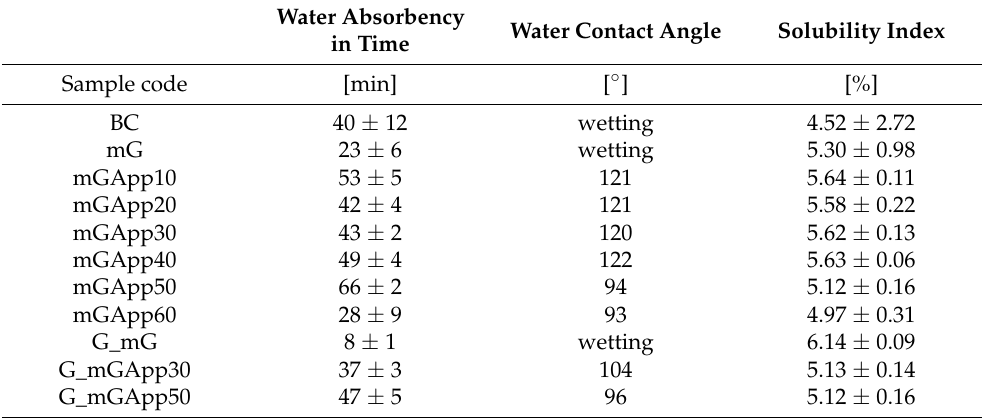
Figure 5. The swelling capacities of materials: bacterial cellulose (BC); bacterial cellulose pre-treated and modified with glycerol (mG and G_mG); bacterial cellulose pre-treated and modified with glyc- erol and by entrapping apple powder (mGApp10; mGApp20; mGApp30; mGApp40; mGApp50; mGApp60; G_mGApp30; and G_mGApp50). ( A ) Bacterial cellulose produced in media without ap- ple powder (mGApp10; mGApp20; mGApp30; mGApp40; mGApp50; and mGApp60); ( B ) bacterial cellulose produced in media with apple powder (G_mGApp30; G_mGApp50). All data are the av- erage of 3 results. Table 1. Water absorbency behavior of the materials. The results are presented as an average (n = 3) ± standard deviation.